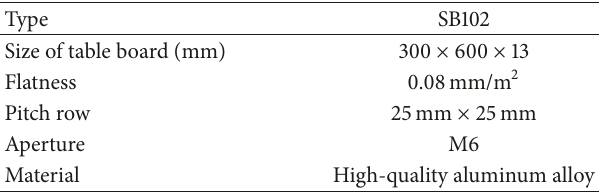
Table 2: Main technical parameters of the scanning system.